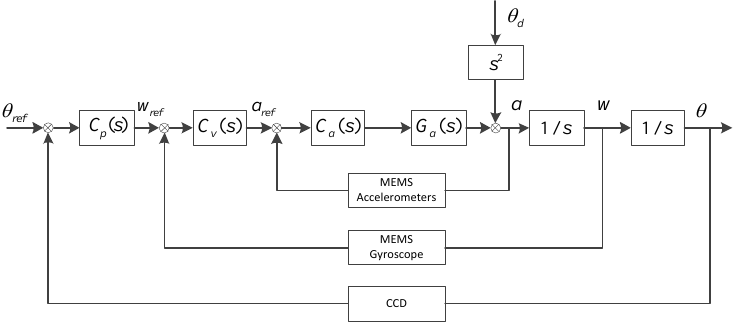
G s is the controlled Figure 2. Classical multi-loop feedback control (MFC) structure. ( ) Figure 2. Classical multi-loop feedback control (MFC) structure. G a ( s ) is the controlled plant, C a ( s ) a C s is the acceleration controller, ( ) C s is the velocity controller, ( ) C s is the plant, ( ) is the acceleration controller, C v ( s ) is the velocity controller, C p ( s ) is the position controller, θ d is the a v p outer disturbance angle ,and θ ref is the given target position.  is the outer disturbance angle ,and  is the given target position controller, ref d position.